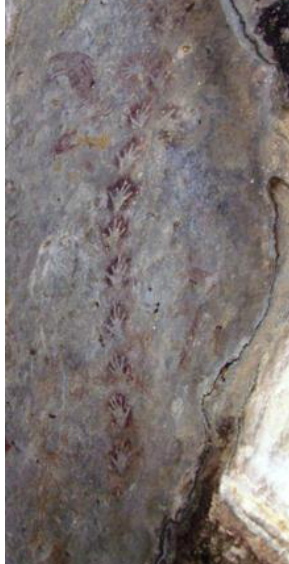
Figure 17. Ceiling panel, Mt Borradaile, Arnhem Land,